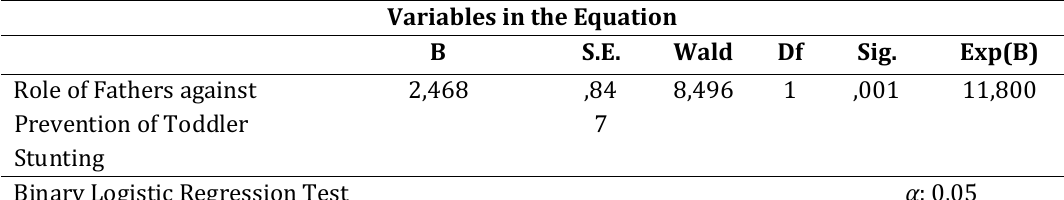
Binary Logistic Regression Test results role of fathers against prevention of toddler stunting Variables in the